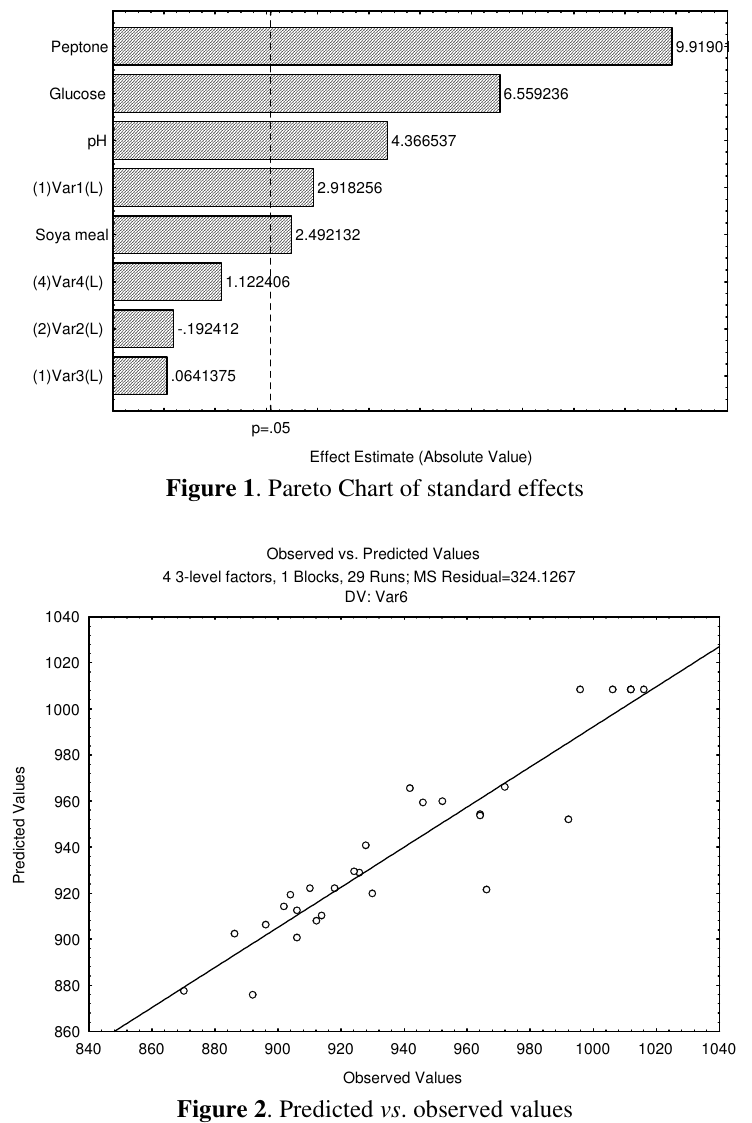
Figure 2 . Predicted vs . observed